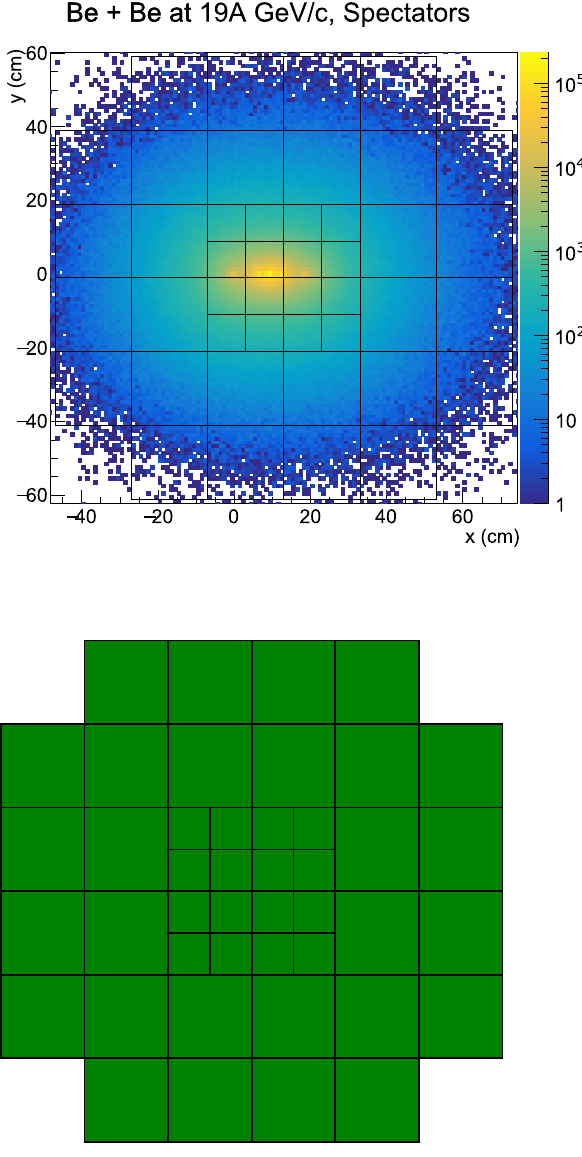
Fig. 6 Upper row: Simulated impact points of particles on the front face of the PSD for beam momentum of 19 A GeV / c (left) and 150 A GeV / c (right). Lower row: PSD modules included in the calcu- 442 GeV for collisions at 19 A , 20 A , 30 A , 40 A , 75 A and 150 A GeV / c , respectively) in order to select the 5% most central collisions (see discussion in Sect.